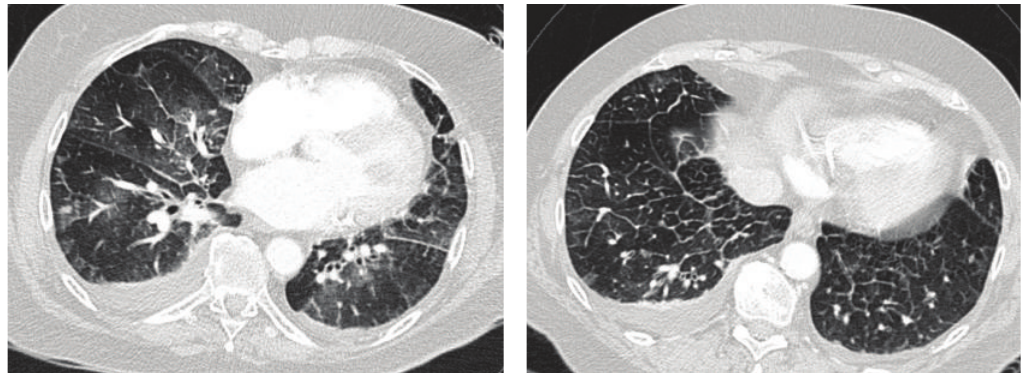
Figure 6: Computed tomography in 77-year-old patients showing signs of congestive heart failure with ground glass opacities, smooth thickening of interlobular septae, and bilateral effusions.